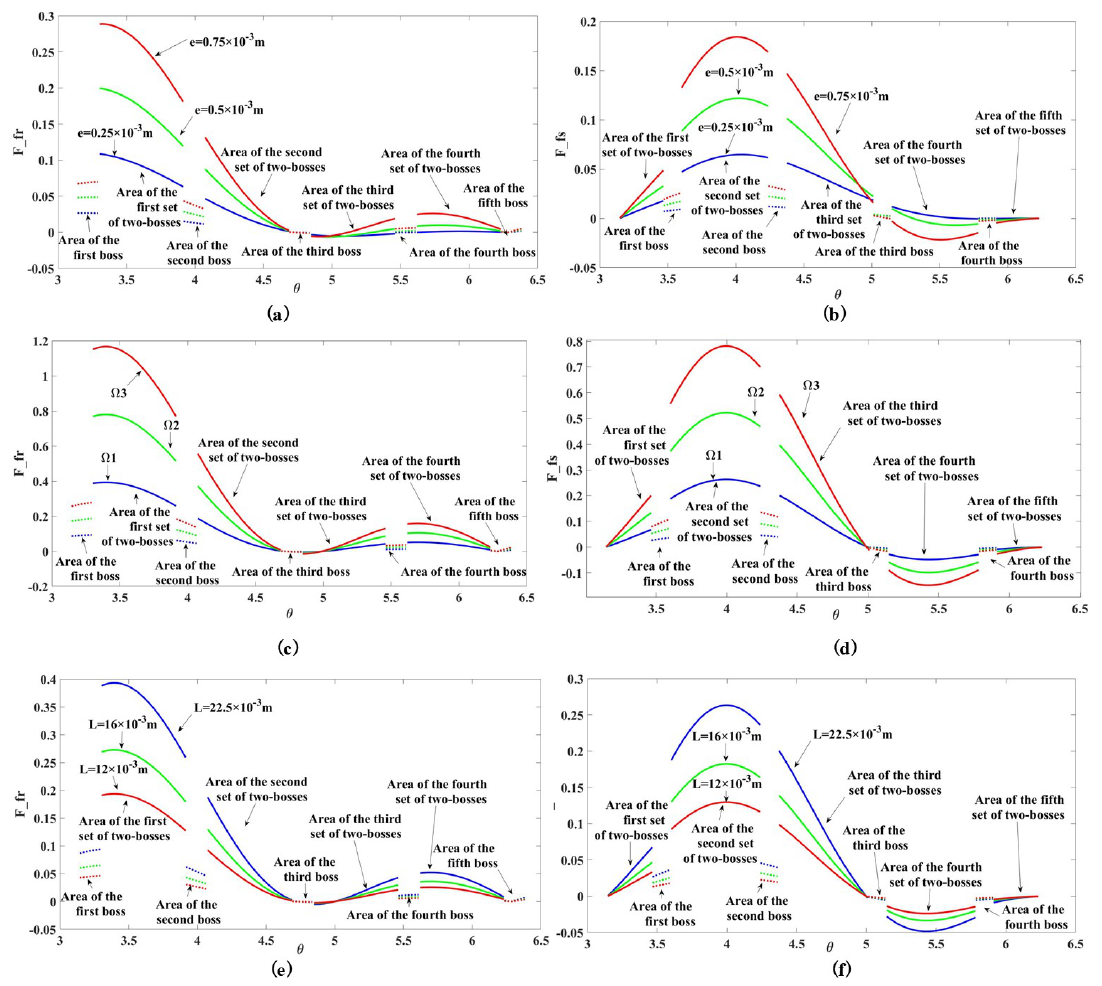
Figure 12. Oil film pressure of end seal on the pressure function. ( a ) Inner oil film force with eccentric. ( b ) Outer oil film force with eccentric. ( c ) Inner oil film force with speed. ( d ) Outer oilf film force with speed. ( e ) Inner oil film force with journal length. ( f ) Outer oil film force with journal length. Table 1. Stiffness (10 3 N/m) and Damping (Ns/m) of the inner oil film of the ERSFD in the suspension. Ratio Boss1 Boss2